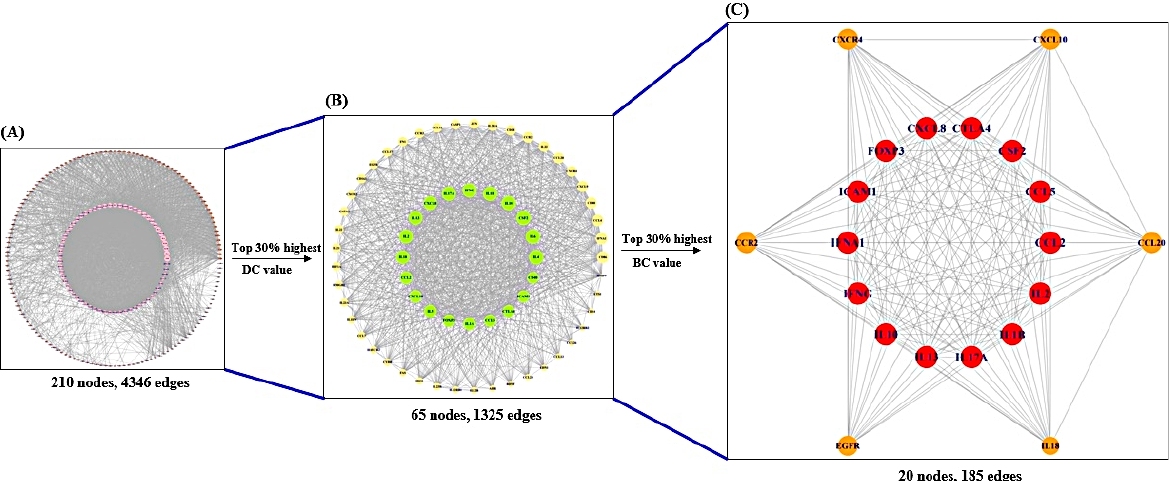
Figure 3. Topological analysis of AM on the PPI network. ( A ) The PPI network of AM targets (210 nodes, 4346 edges). ( B ) The PPI network of significant targets filtered from A (65 nodes, 1325 edges). ( C ) The PPI network of the uppermost targets against AM filtered from B (20 nodes, 185 edges). Based on the top 30% of the subnetwork by betweenness centrality (BC), 14 out of 20 targets had the same degree centrality (19) (Table 1), which were determined as crucial